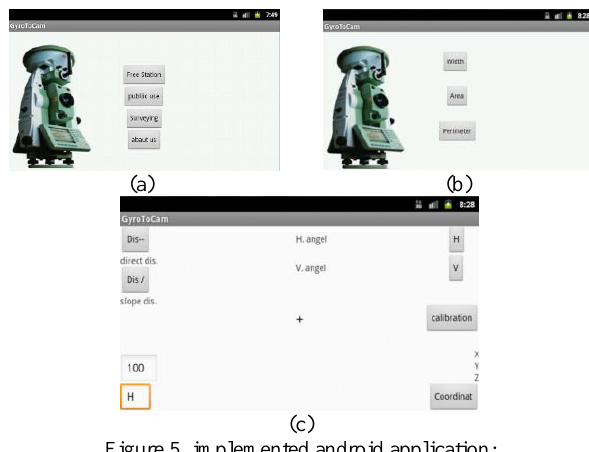
Figure 5, implemented android application: